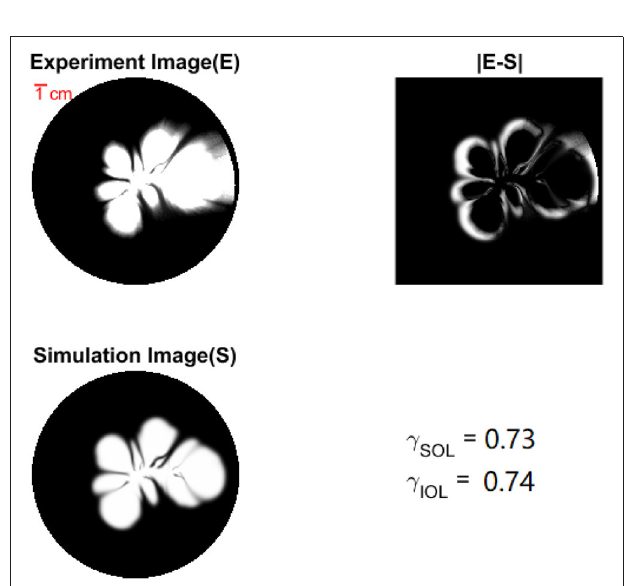
E S displays the intensity | − |